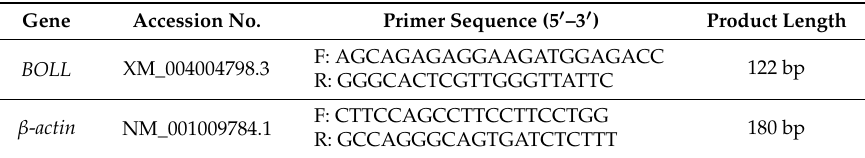
Table 1. List of the primers used in